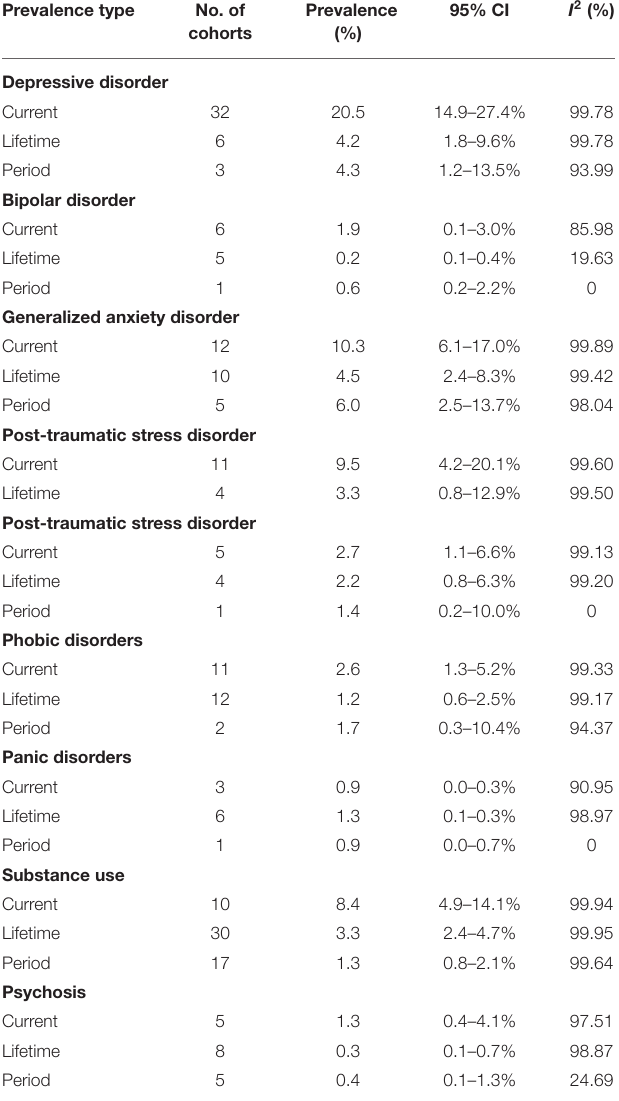
TABLE 2 | Mental disorders in the EMR by type of prevalence. Prevalence type